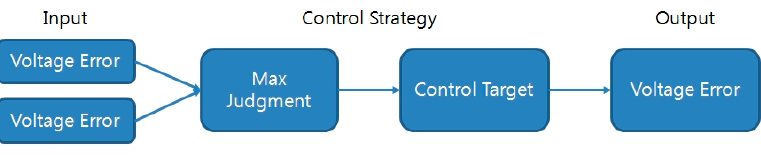
Energies 2019 , 12 , x FOR PEER REVIEW Figure 5. Concept underlying the second process in the dead-band step. Figure 5. Concept underlying the second process in the dead-band step.